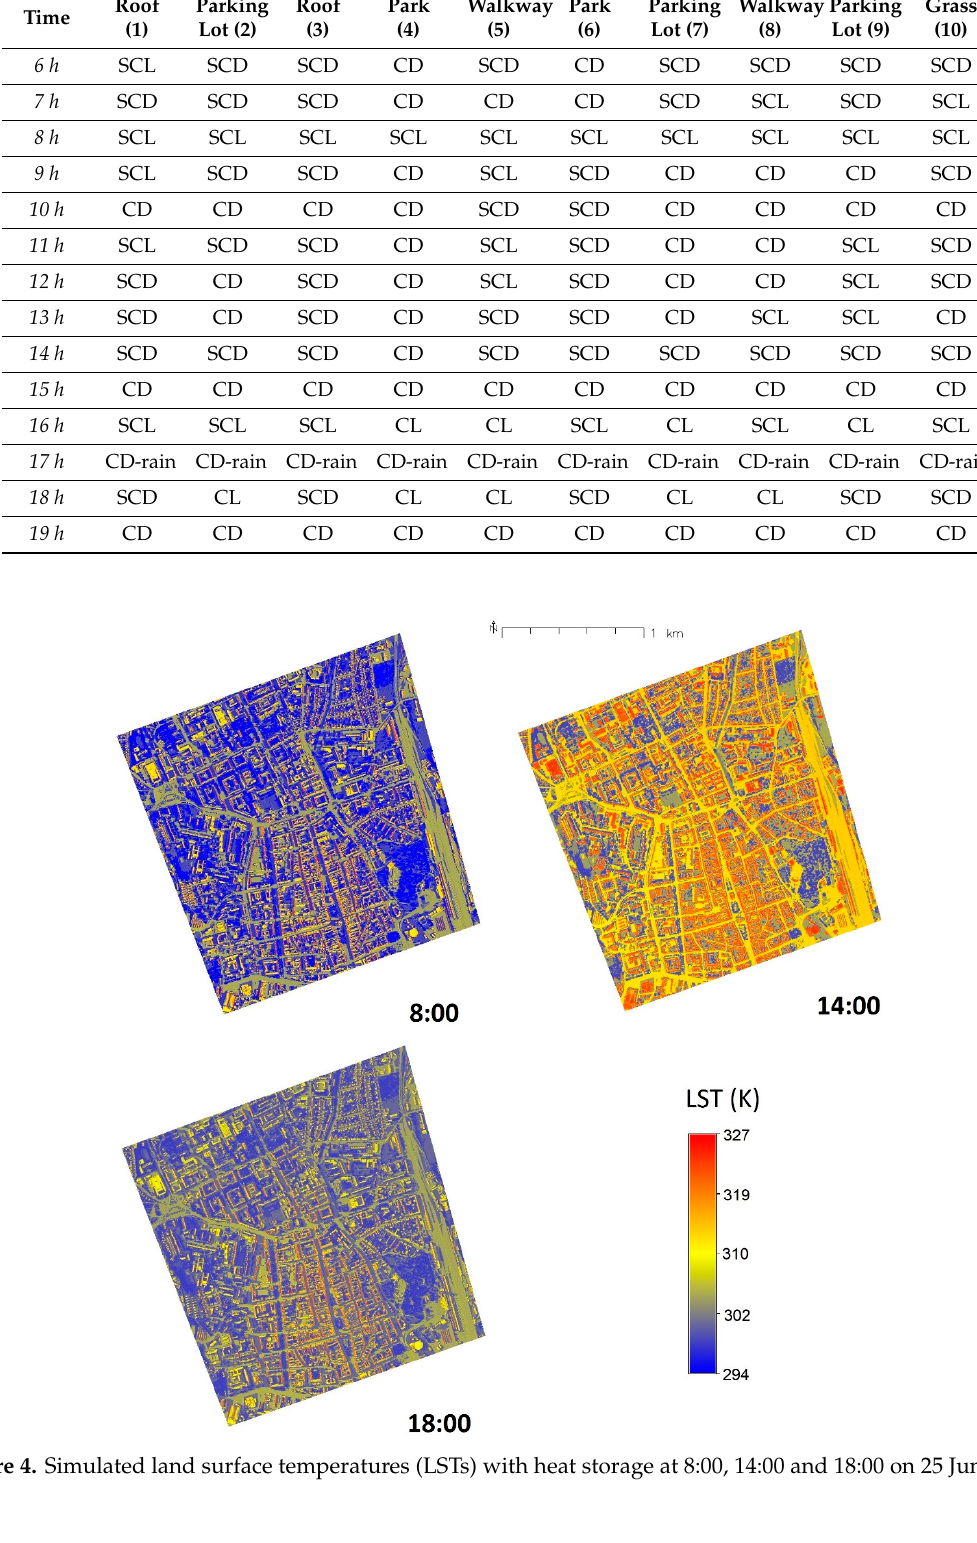
Figure 4. Simulated land surface temperatures (LSTs) with heat storage at 8:00, 14:00 and 18:00 on